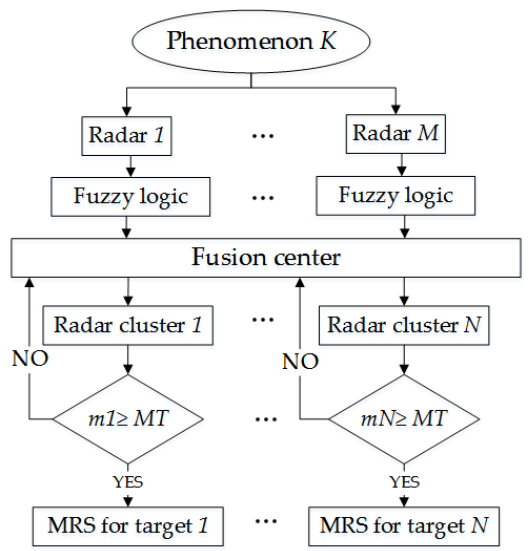
Figure 2. Flow chart of radar clustering.